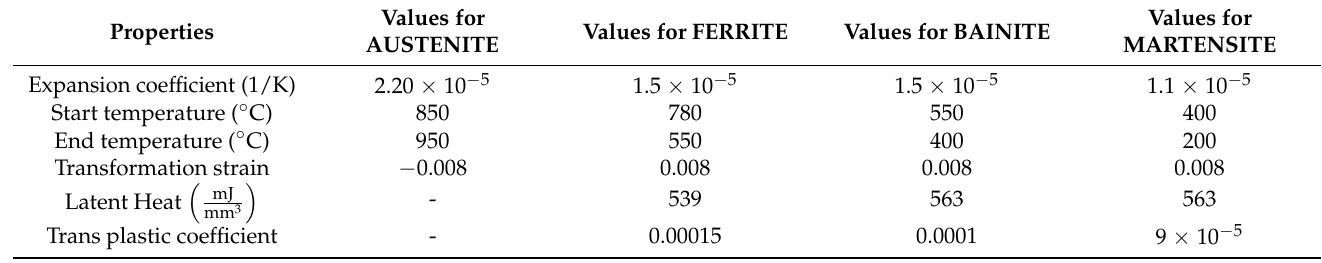
Table 5. Physical properties for each microstructural phase.